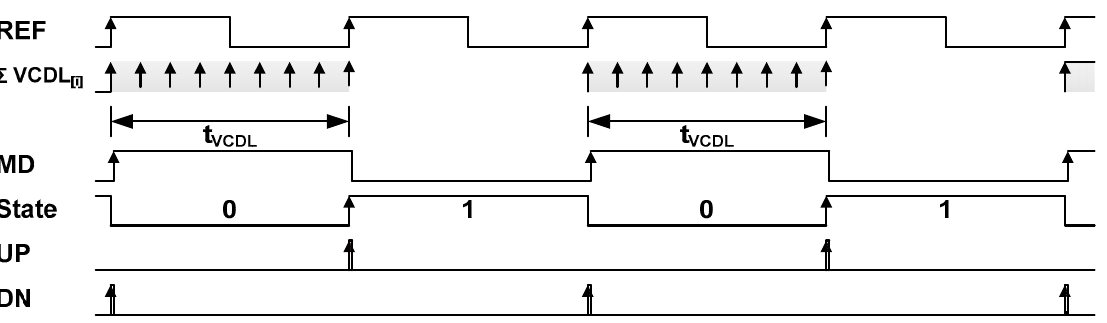
Figure 8. Timing diagram under condition of DLL locking with PD-MDV.